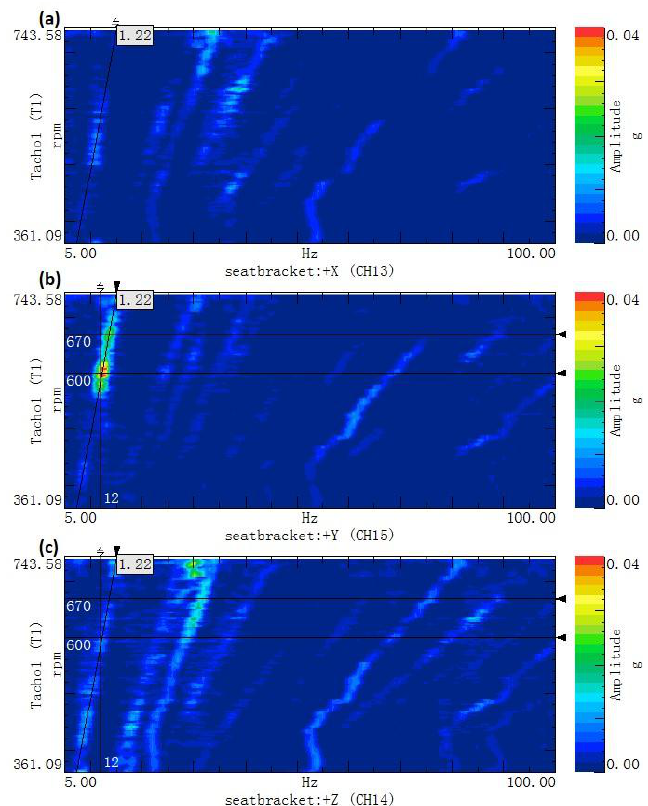
Figure 4. The order tracking colormap of the acceleration: ( a ) x direction; ( b ) y direction and ( c ) z direction.